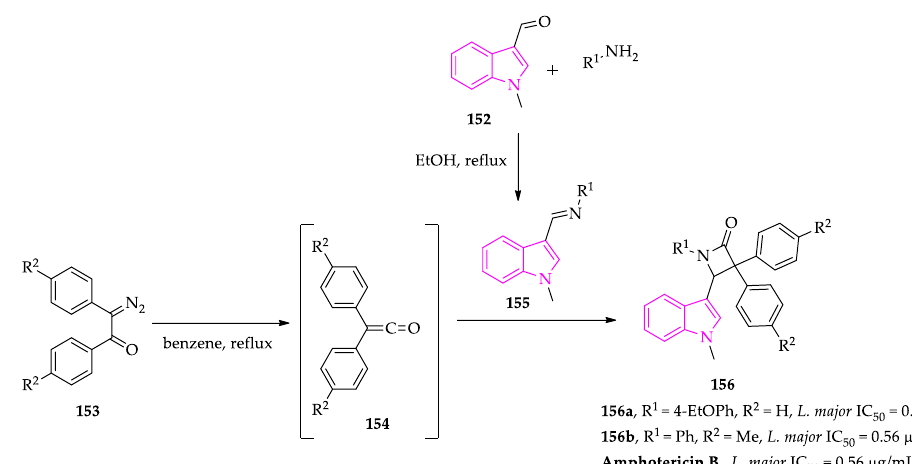
Scheme 13. Indole-based azetidin-2-ones with antileishmanial activity.